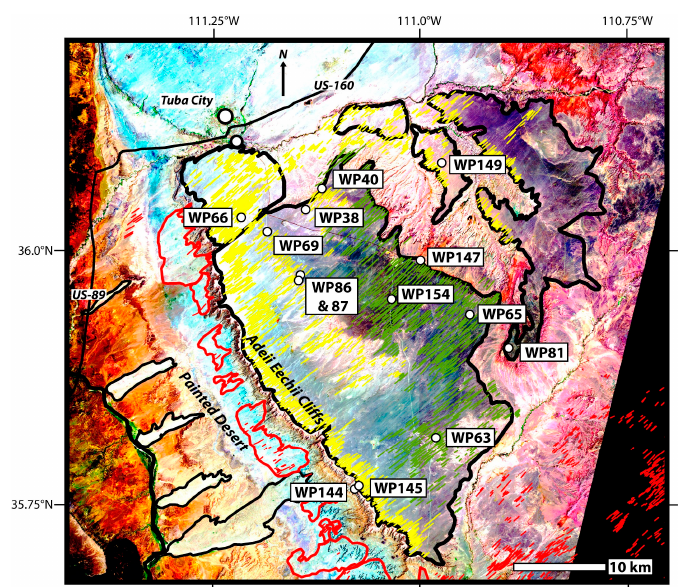
Figure 4. Landsat scene from June, 2000 in 2-4-7 band combination (RGB). Stable linear dunes are depicted as green lines, active linear dune crests with stable plinths in yellow, completely active linear dunes in red. Painted Desert floodplain-adjacent dunes are polygons outlined with thin black lines, bedrock-adjacent dune polygons are outlined in red. Sand sheets of the Moenkopi Plateau are shown as polygons outlined with the thick black lines. Soil profiles are labeled.